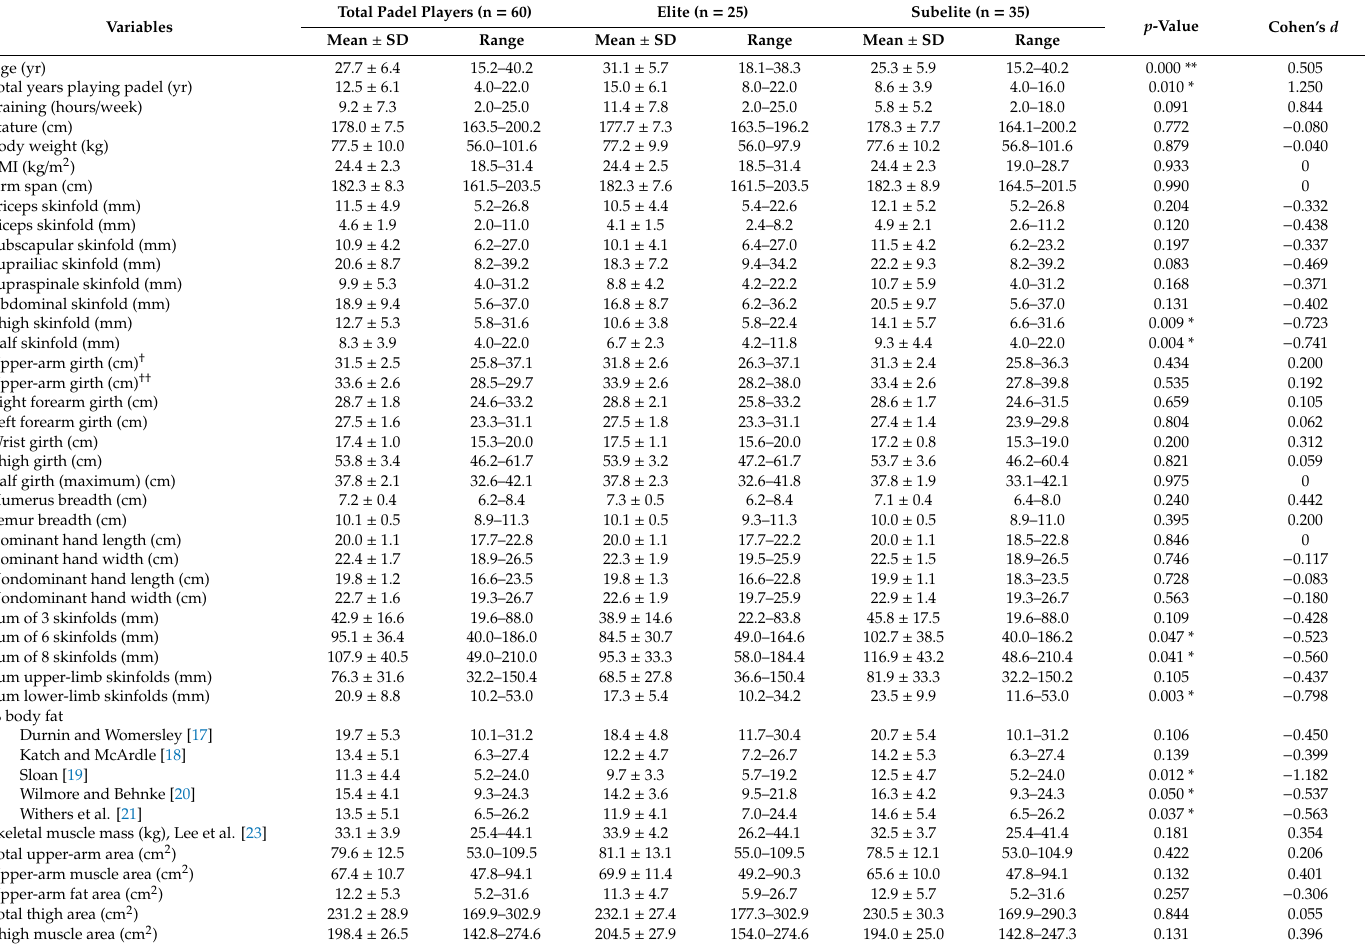
Table 1. Anthropometric and physical characteristics of the total sample, and elite and subelite padel